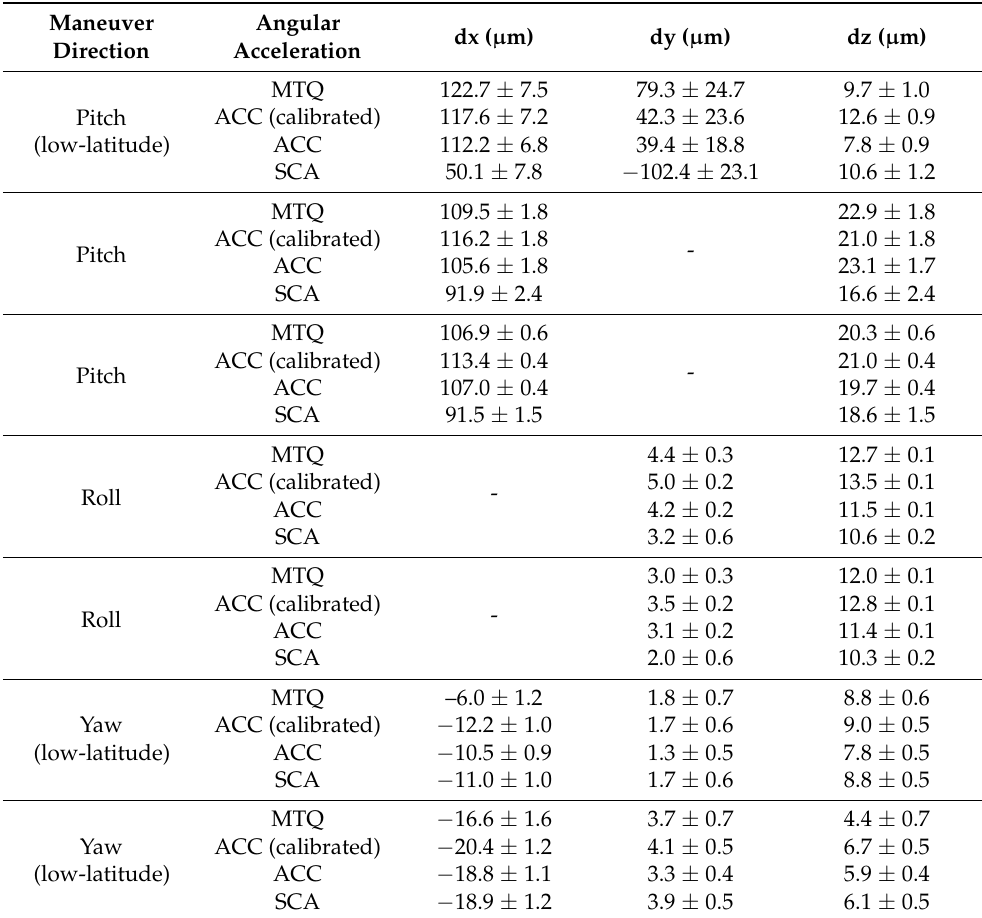
Table 7. CM-offset based on MTQ, ACC (calibrated), ACC, and SCA angular acceleration. Maneuver Angular Direction